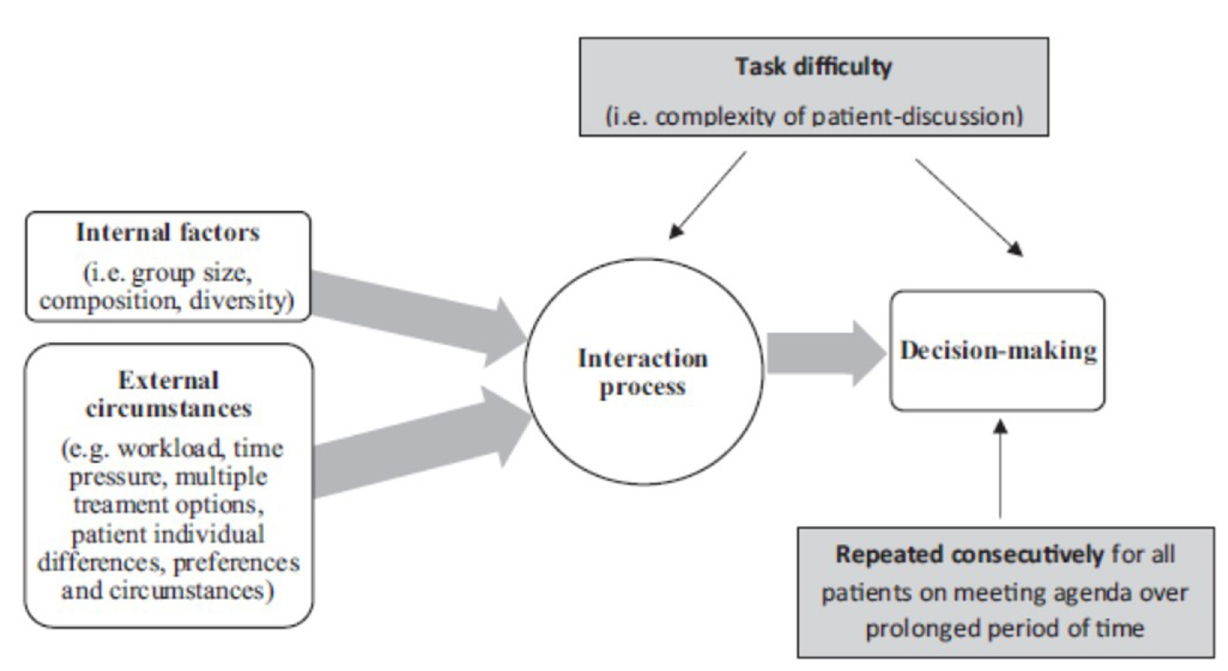
FIGURE1 Graphic representation of the factors affecting cancer team functioning and communication in line with the functional perspective of group decision-making. This diagram demonstrates the functional perspective of group decision-making graphically with the interaction process and communication at the center of the process. Reprinted with permission from the following two sources: (Soukup, 2017) “Socio-cognitive factors that affect decision-making in cancer multidisciplinary team meetings [Doctoral thesis, Imperial College London]” Spiral Repository, https://doi.org/10. 25560/79603 by Soukup (2017); and (Soukup et al., 2020a) “A multicenter observational cross-sectional observational study of cancer multi- disciplinary teams: analysis of team decision-making” by Soukup et al. (2021c), Cancer Medicine,